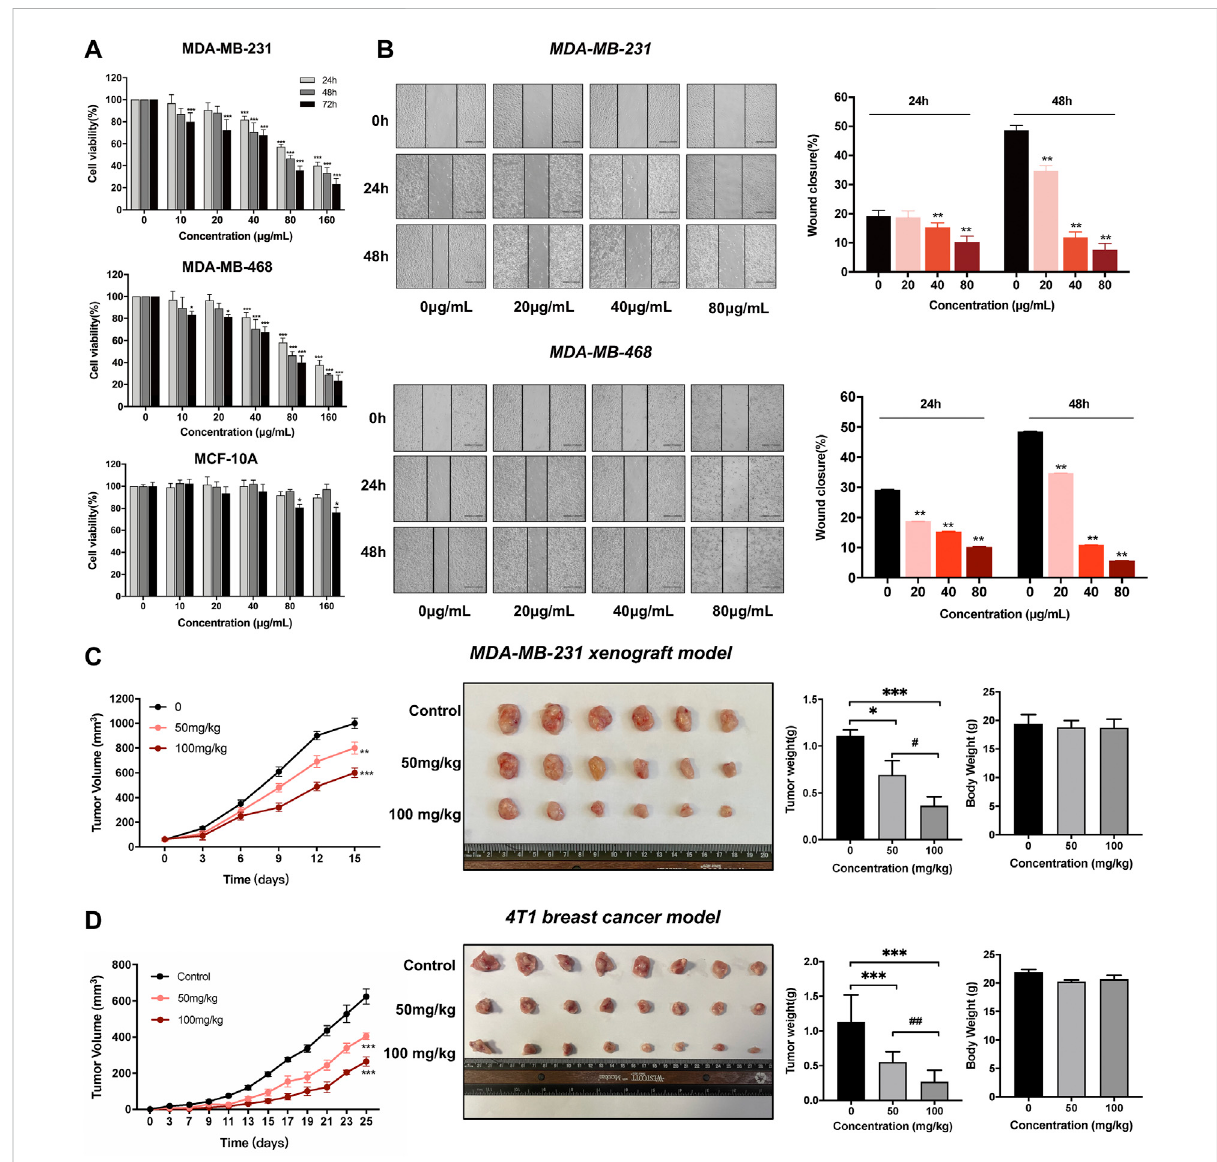
FIGURE 2 Dandelion extract inhibited TNBC cells malignant phenotypes and tumor growth in breast cancer mice model. (A) Dandelion extract inhibited cell proliferation on MDA-MB-231, MDA-MB-468, and MCF-10A. *p < 0.05 , **p < 0.01 , ***p < 0.005 vs. 24 h. (B) Dandelion extract inhibited TNBC cellmigrationinadose-dependentmanner. *p < 0.05 , **p < 0.01 , ***p < 0.005 vs.0 μ g/ml (C) Dandelionextract reduced thetumorgrowth inMDA- MB-231 xenograft model. (D) Dandelion extract reduced the tumor growth in 4T1BALB/C mice model. *p < 0.05 , **p < 0.01 , ***p < 0.001